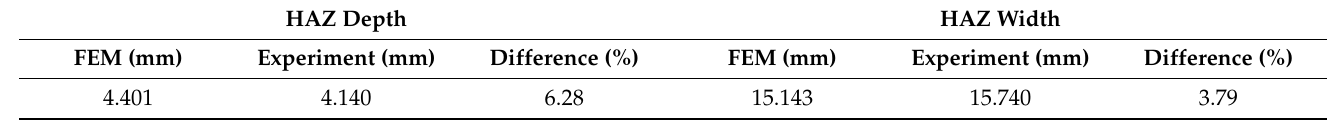
Figure 11. Heat transfer analysis results. Times were ( a ) 0 s after the welding heat source has passed (Max HAZ width); ( b ) 1.6 s after the welding heat source has passed (Max HAZ Depth). Table 8 . HAZ dimension and comparison .